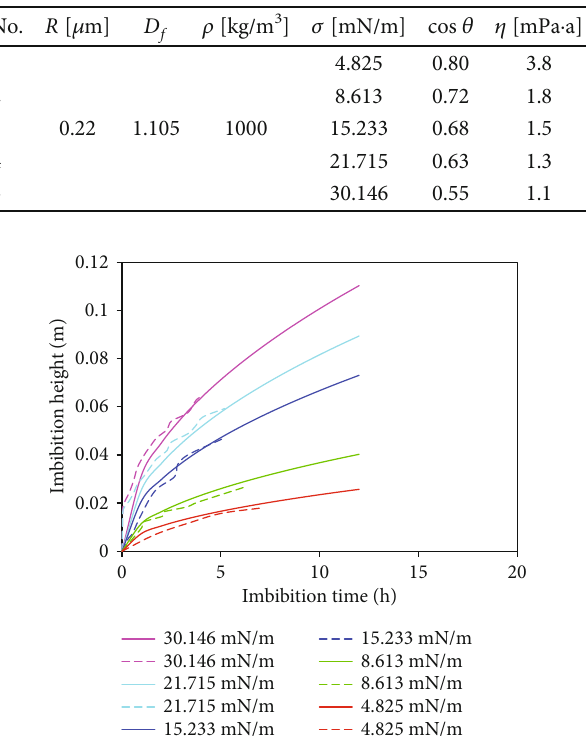
Table 3: Basic parameters of cores and imbibition solution.